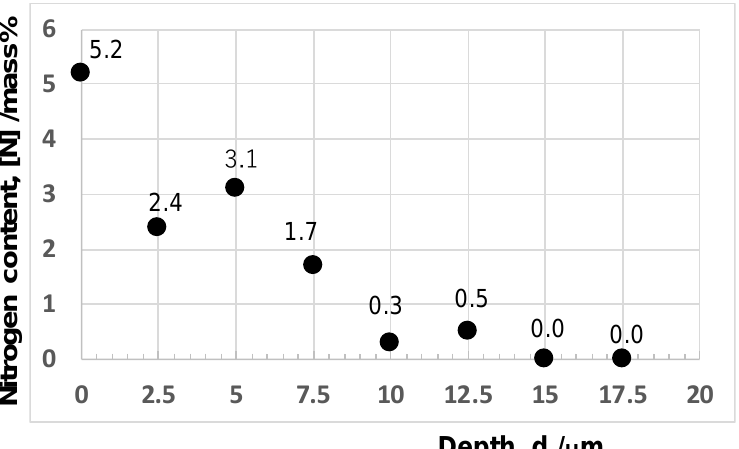
Figure 4. SEM image and nitrogen mapping on the cross-section of nitrided AISI420 at 673 K for 3.6 ks; ( a ) SEM image; ( b ) nitrogen mapping by EDX.